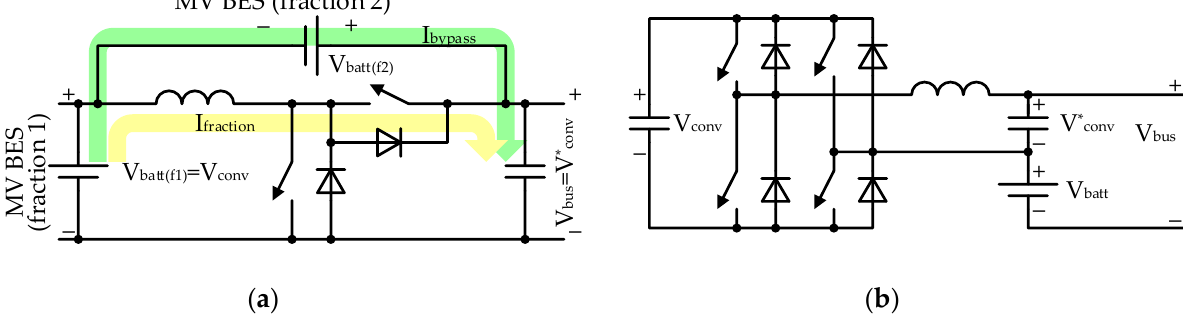
Figure 25. Specific kinds of FPC: ( a ) FPC synthesized from “non-isolated” synchronous buck PPC, ( b ) fractional power conversion with “virtual fraction” [ 139].